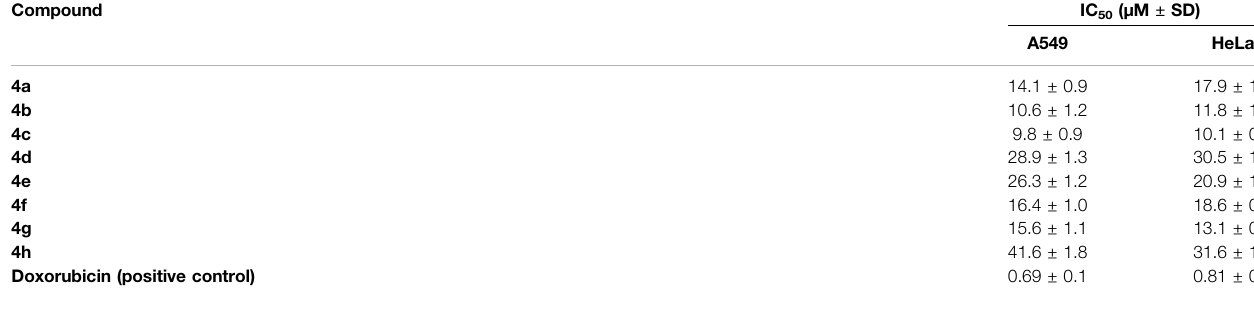
TABLE 3 | Cytotoxicity and structure activity relationship of novel pyran-linked phthalazinone-pyrazole hybrids 4a – h .